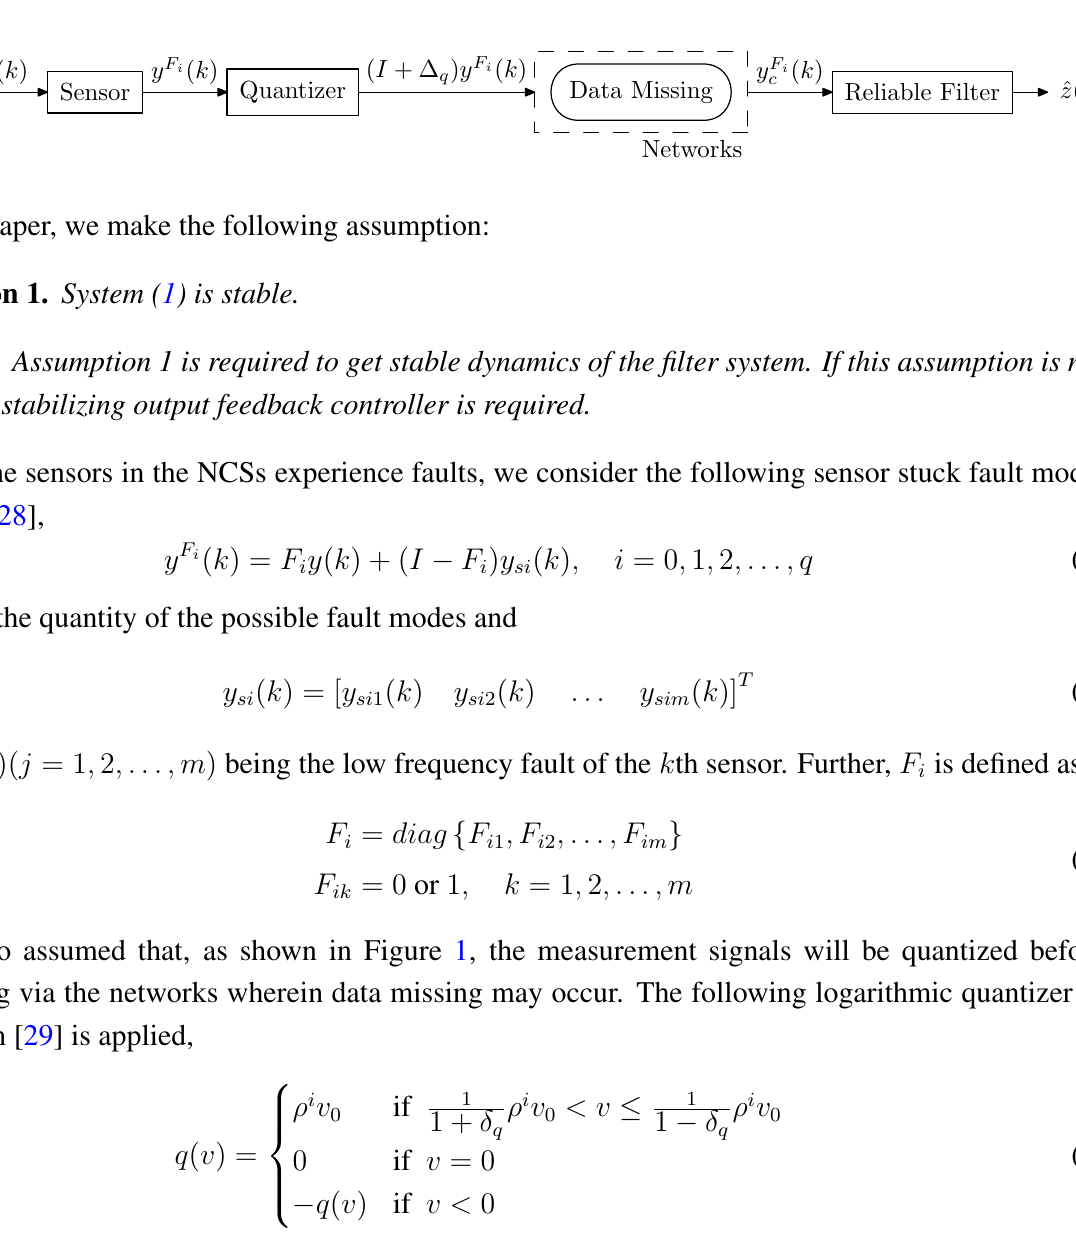
Figure 1. Structure of the Networked Control